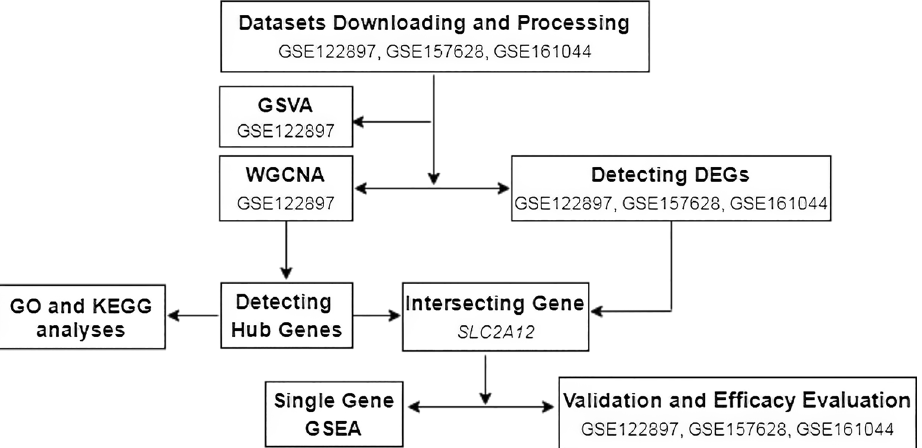
Figure 1. Flowchart on construction and validation of the pathogenesis-related gene of IA occurrence. IA, intracranial aneurysm; WGCNA, Weighted gene co-expression network analysis; GEO, Gene Expression Omnibus; DEGs, differential expressed genes; GO, Gene Ontology; KEGG, Kyoto Encyclopedia of Genes and Genomes; GSVA, Gene Set Variation Analysis; GSEA, Gene Set Enrichment Analysis; This flowchart was generated and edited with the free application online, diagrams.net (https:// app. diagr ams.